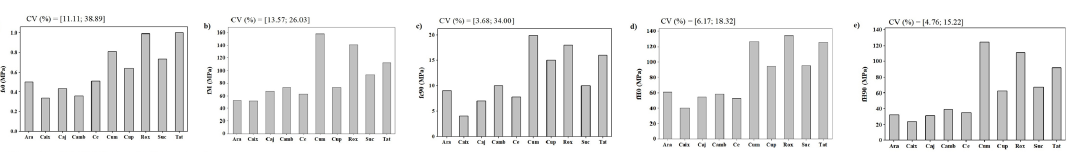
), s0 ), (d) hardness of the c90